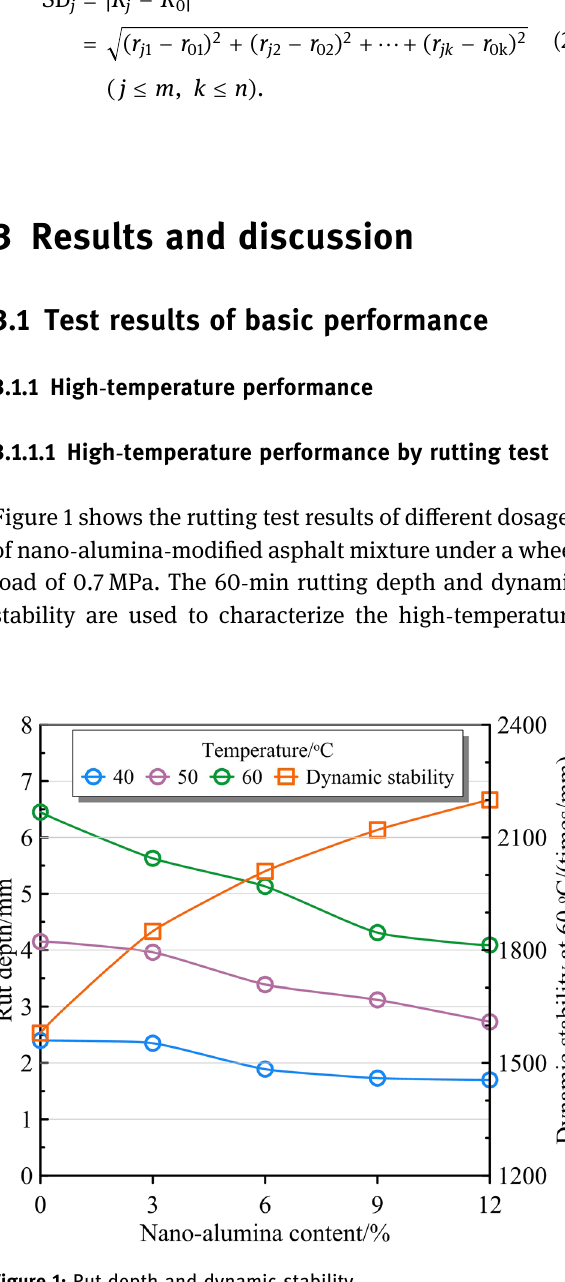
Figure 1: Rut depth and dynamic stability. Figure 2: Cumulative permanent